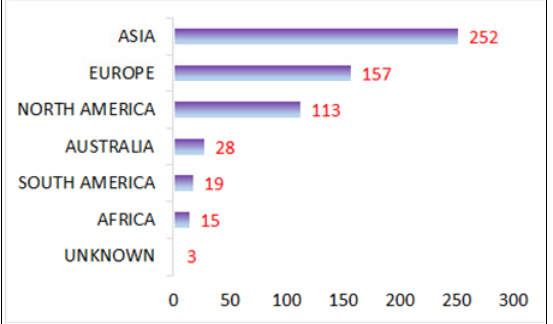
Figure 7. Number of articles published on different continents.